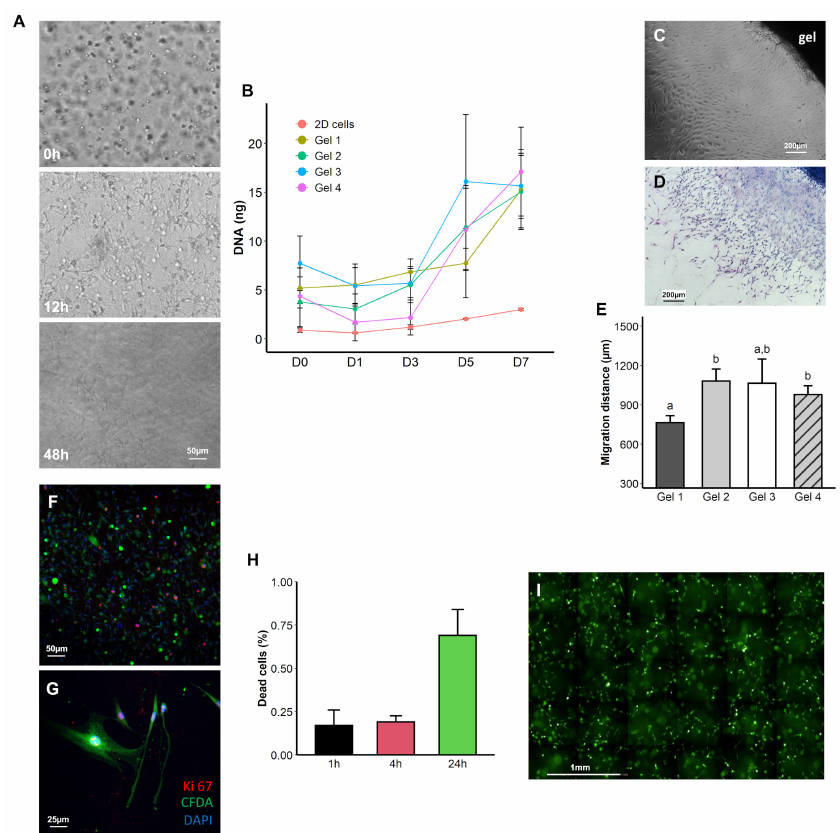
Figure 4. In vitro ASC features in PLFH. ( A ) Light microscopy visualization of ASC inside Gel 2 immediately after the formation of the PLFH biohybrid, at 12 and 48 h. Starting with a rounded shape when not yet adherent, ASC progressively acquired a "fibroblastic" star-like appearance, showing spreading and adhesion within the matrix network. ( B ) Evaluation of cell proliferation in the PLFH by DNA quantification. DNA amounts increased between day 3 and day 5. Cells left adherent on plastic were used as a control (2D cells). ( C , D ) Visualization at day 5 of ASC that have migrated out of the hydrogel (Gel 2), by light microscopy ( C ) and after fixation and staining with May-Grünwald Giemsa ( D ). ( E ) Evaluation of the average migration distance (in µm) by measuring the distance between the hydrogel and the migration front at day 5. Low ( F ) and high ( G ) magnification Ki-67 immunostaining of PLFH/ASC (Gel 2) showing proliferating ASC (red nuclei staining) 72 h after being seeded inside the hydrogel. CFDA and DAPI stained cell cytoplasm and nuclei, respectively. ( H , I ) CFDA/DAPI staining and Operetta® microscopy for assessment of ASC viability inside Gel 2. Quantification of cell viability 4 and 24h after cell seeding inside PLFH displays less than 1% of dead cells (DAPI positive, blue) from total ASC population. An identical letter indicates non-significant